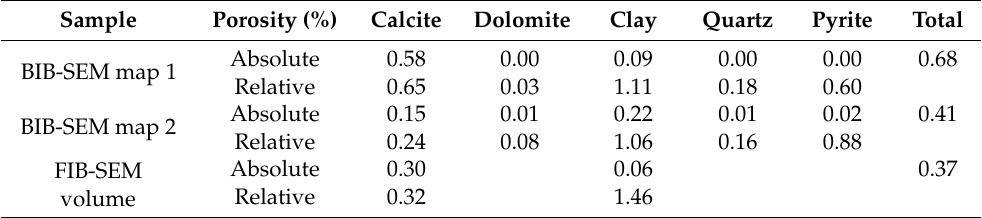
Table 2. Absolute and relative porosities of different mineral phases in BIB-SEM maps and FIB-SEM volume (relative porosity is the ratio of pore area or volume to the area or volume of a specific mineral; absolute porosity is the ratio of pore area or volume to the total area or volume of all mineral phases). Sample Porosity (%) Calcite Dolomite Clay Quartz Pyrite Total Absolute BIB-SEM map 1